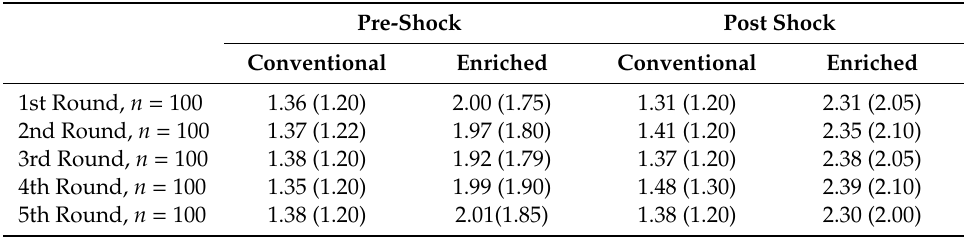
Table 4. Summary of Mean and Median (in parenthesis) willingness to pay (WTP) by Products and